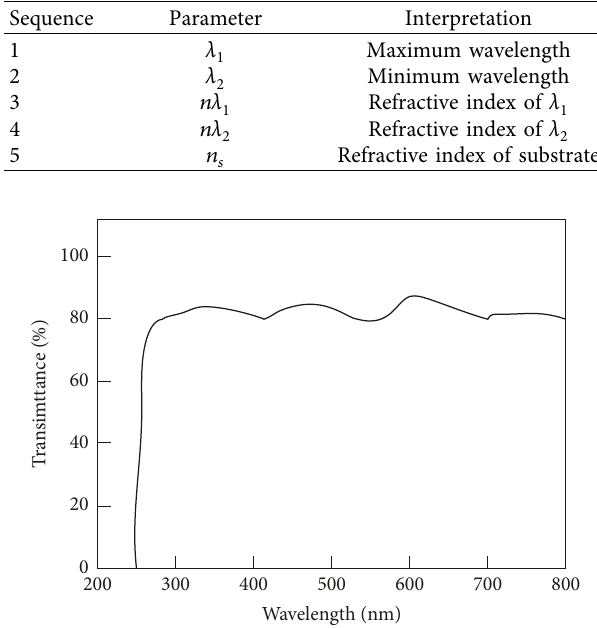
Figure 4: Transmittance spectrum of nanomaterial